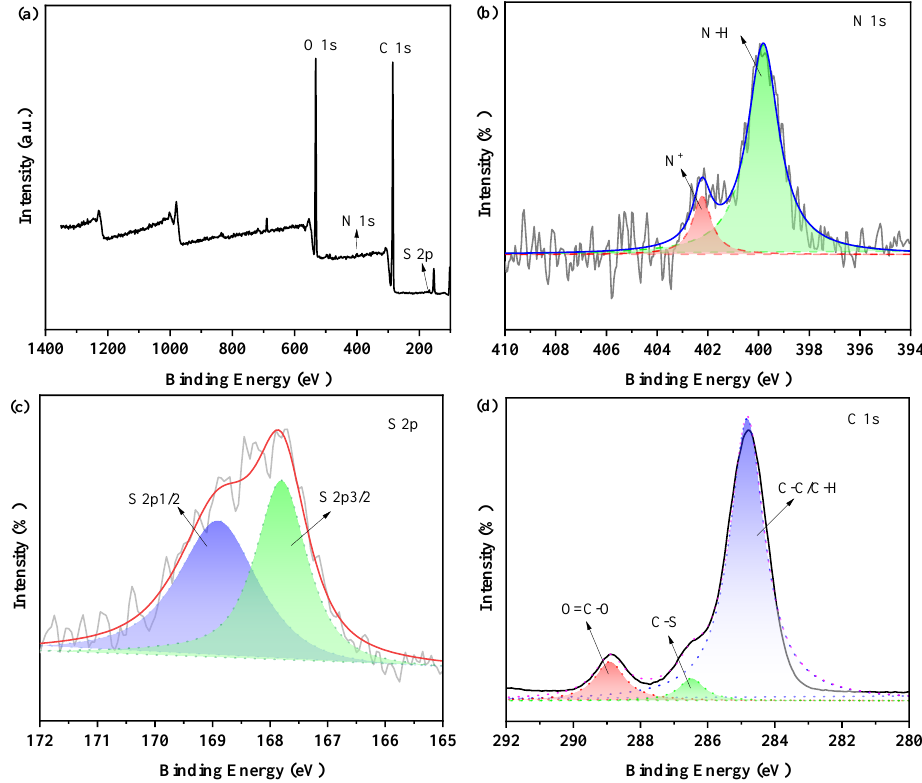
Figure 3. ( a ) XPS wide spectrum of ZPU; high-resolution XPS spectra of the N 1s ( b ), S 2p ( c ), and C 1s ( d ), respectively.